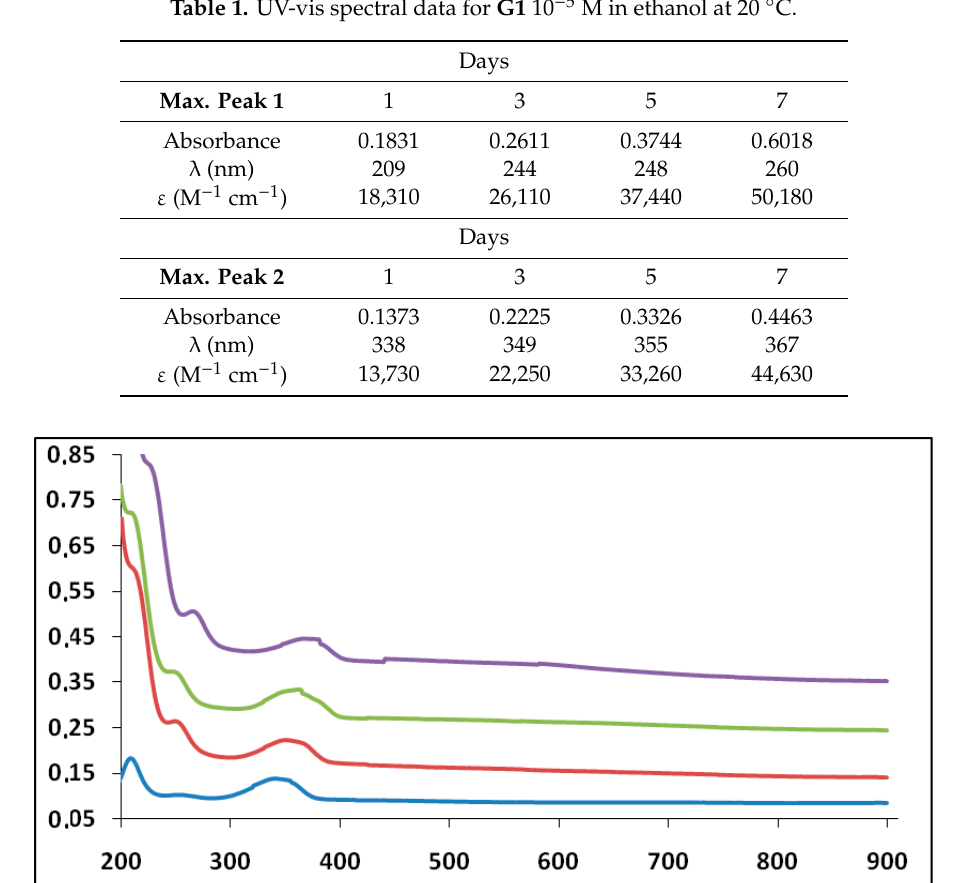
Figure 6. UV-vis spectra (A vs. λ nm) for compound G1 10 − 5 M on different days at 20 °C (ethanol as solvent). Day 1 (blue line). Day 3 (red line). Day 5 (green line). Day 7 (violet line) from the preparation of the solution.